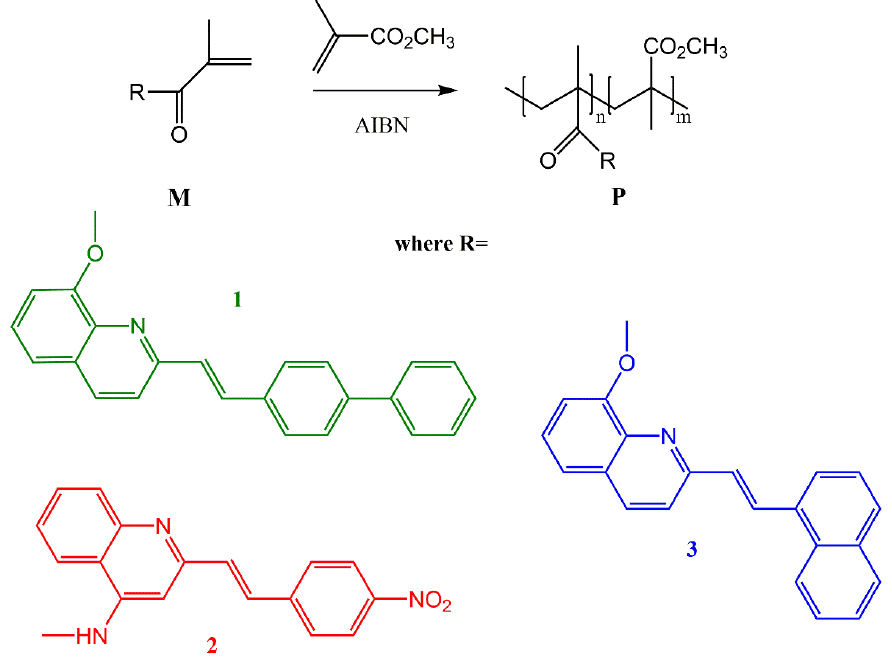
Figure 1. Synthesis of styrylquinoline copolymers by free radical polymerization P1, P2, and P3.